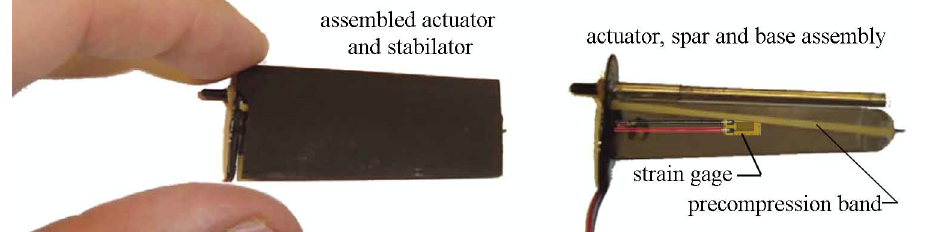
Figure 12. Flexspar Actuator Assembly and Flexspar Stabilator.